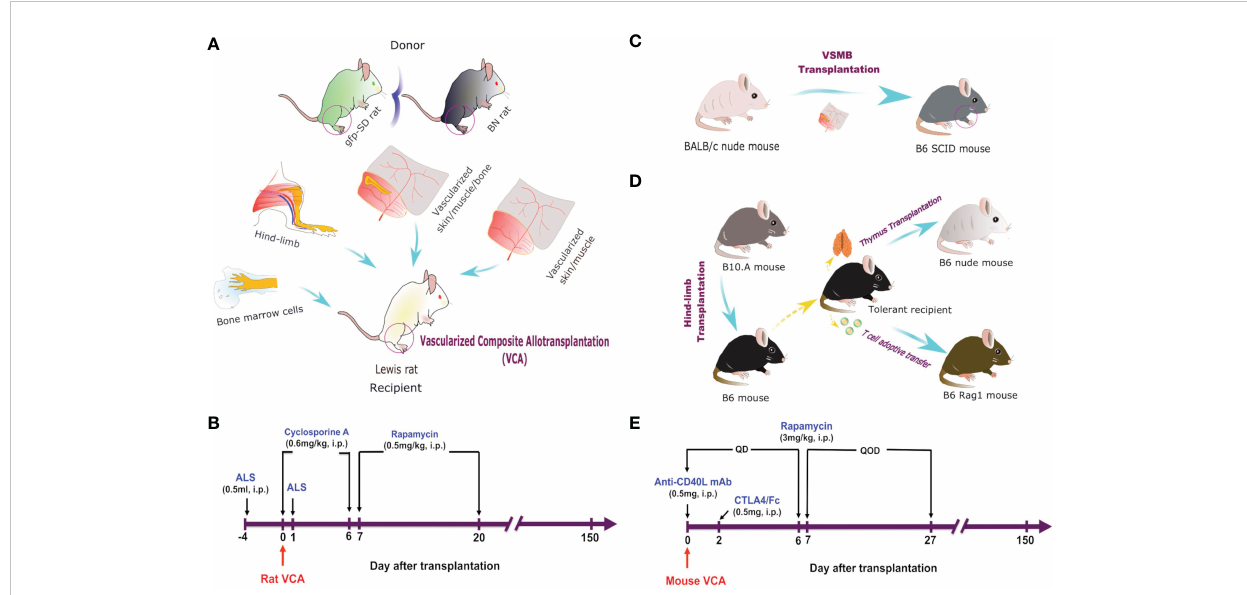
FIGURE 1 VCA models and immunosuppressive regimes. (A) Hind-limb, VSMB, VSM, and BMC (50 x 10 6 ) transplantation from either BN or gfp-SD donor rats to LEW rat recipients. (B) Recipient rats were sequentially treated i.p. with ALS, cyclosporine A, and rapamycin for 21 days. (C) VSMB or VSM transplantation from BALB/c nude mice to B6 SCID mice. (D) Hindlimb transplantation from B10.A mice to B6 mice. Thymus transplantation and T cell adoptive transfer were performed from tolerant recipients to B6 nude mice. (E) VCA recipient mice were treated i.p. with anti-CD40L mAb, CTLA4/Fc, and rapamycin for 28